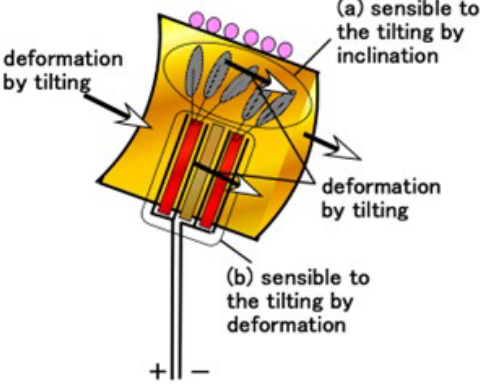
Figure 12. Schematic of physical model of equilibrium performance by inclination of equilibrium sensor mimicking a saccule. sensor mimicking a